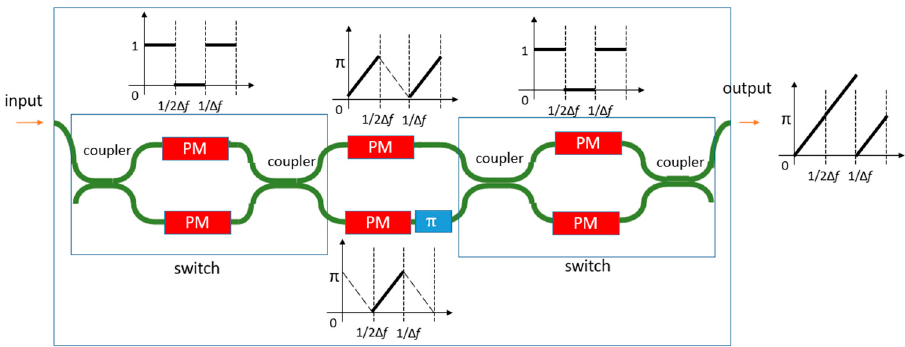
Figure 11. Schematic diagram of an optical frequency shifter based on the switch-serrodyne method.